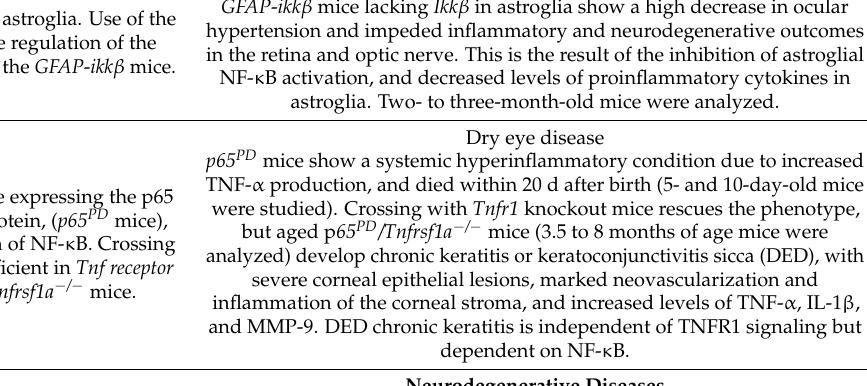
Table 2. Mouse models of the NF- κ B signaling pathway resembling ageing-associated human diseases. NF- κ B Gene Genetic Modification Recapitulated Disease and Proposed Mechanisms Eye